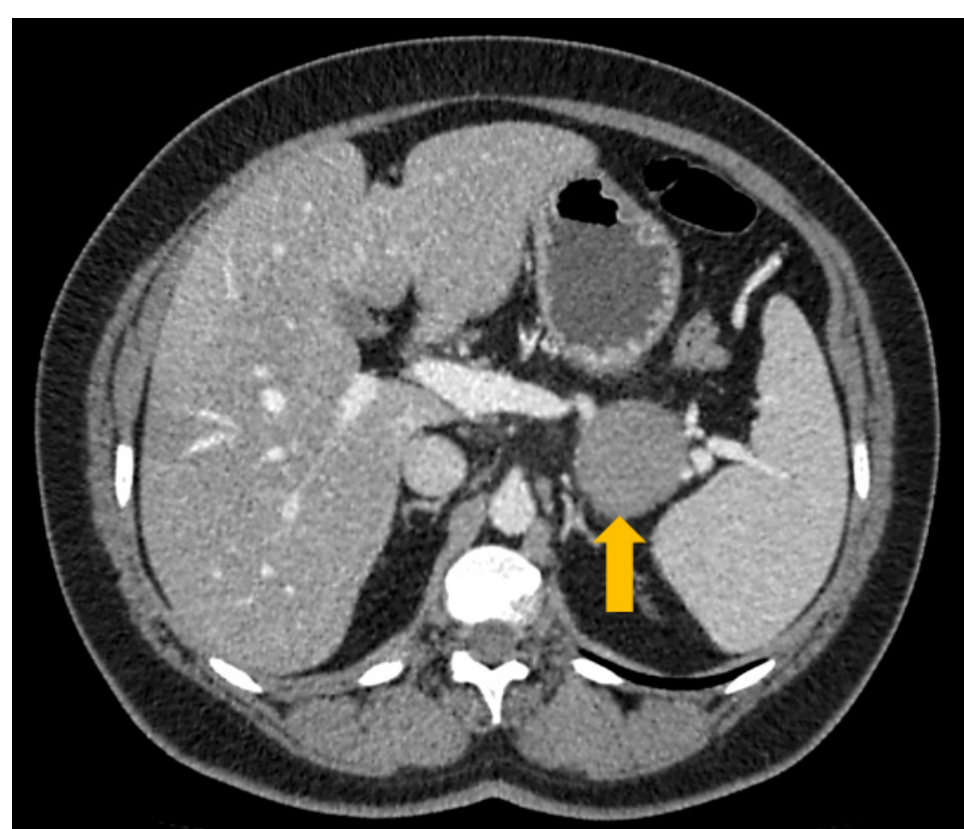
Figure 2 . CT scan showing the presence of a roundish mass (4.5 cm, yellow arrow) between the stomach and the spleen.